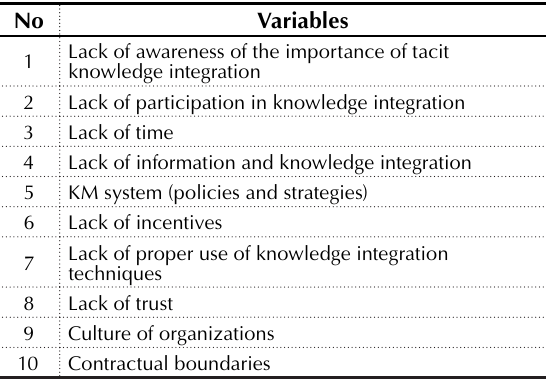
Table 3. KI challenges within the